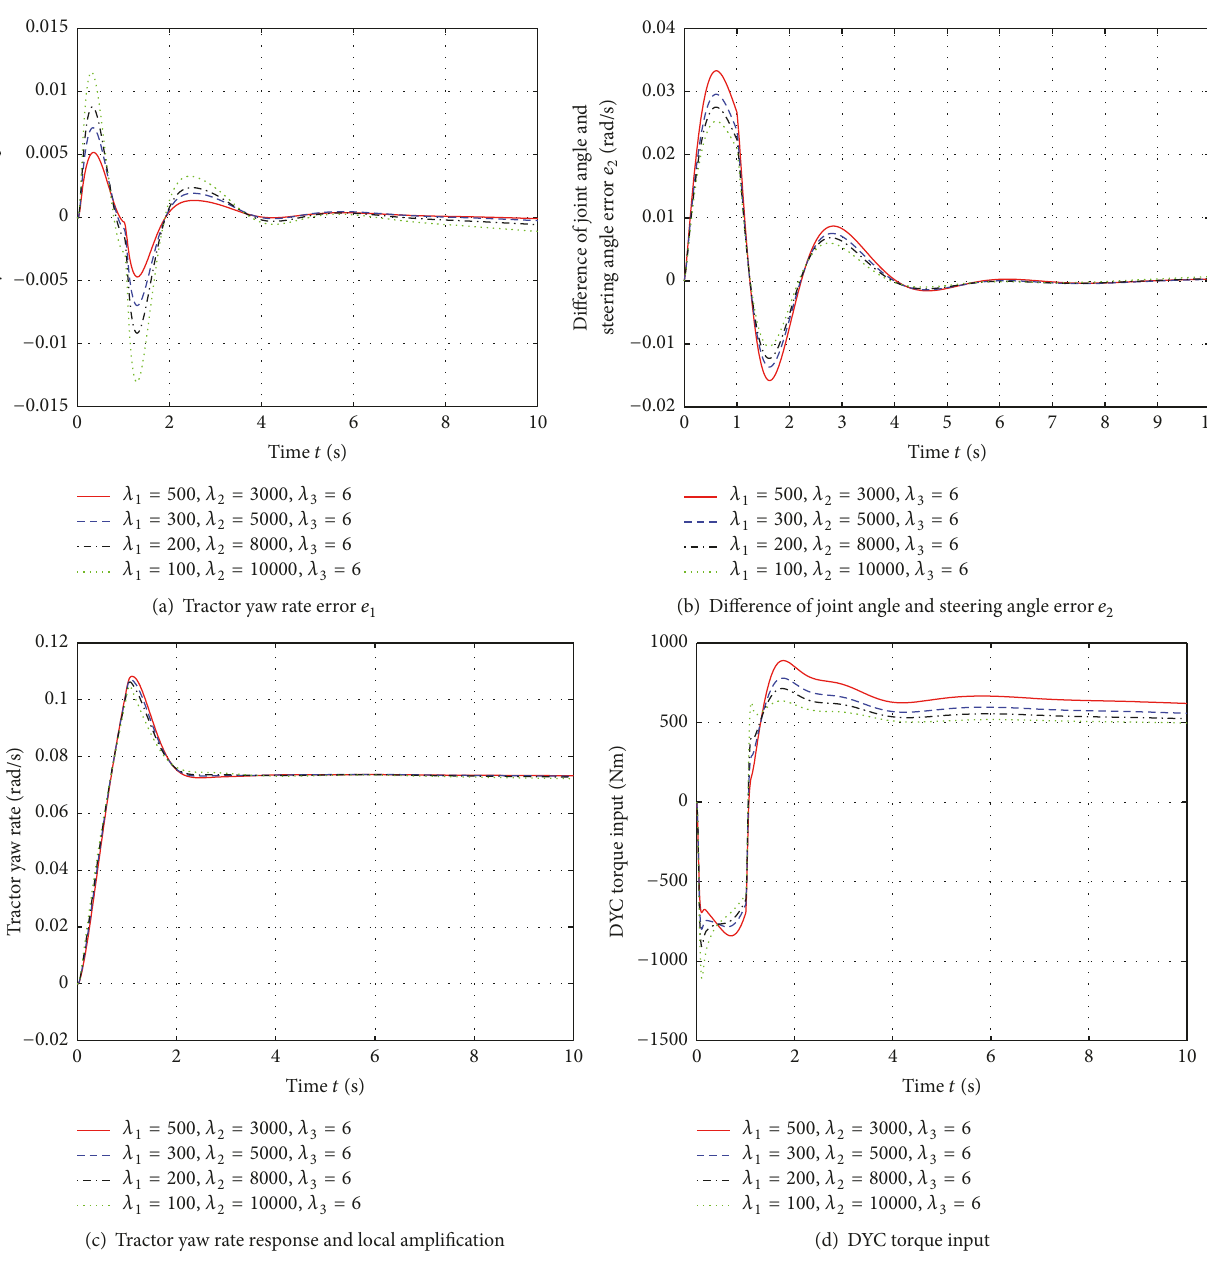
Figure 9: Control effects with 4 sets of data.